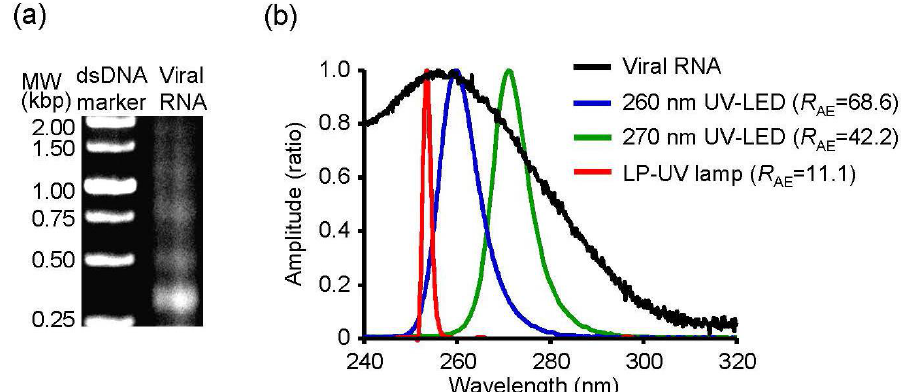
Figure 5. Absorbance spectrum of viral RNA and emission spectrum of UV irradiations. ( a ) A representative image of agarose gel electrophoresis for purified viral RNA. ( b ) Absorbance spectrum of viral RNA and emission spectrum of UV irradiations. R AE score indicates the correlation coefficient between the absorbance spectrum of viral RNA and emission spectrums of UV irradiations.